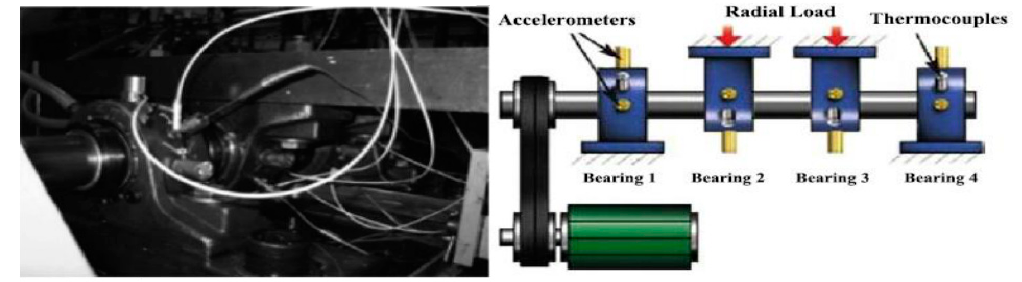
Figure 3. The experimental setup.